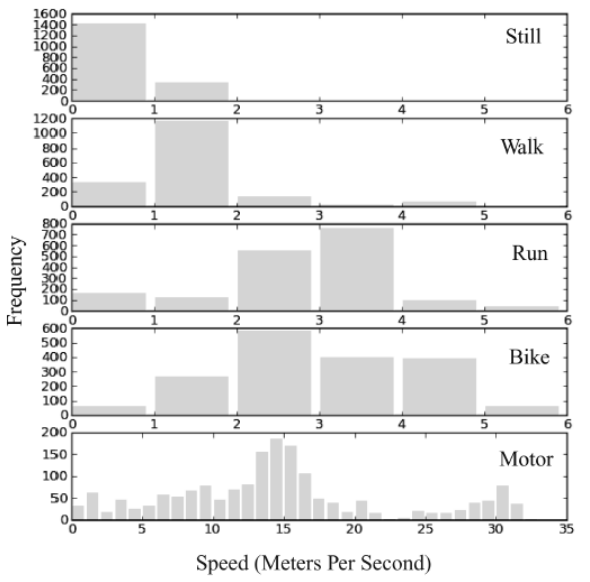
Figure 5 . Distribution of speeds for the transportation modes [10].